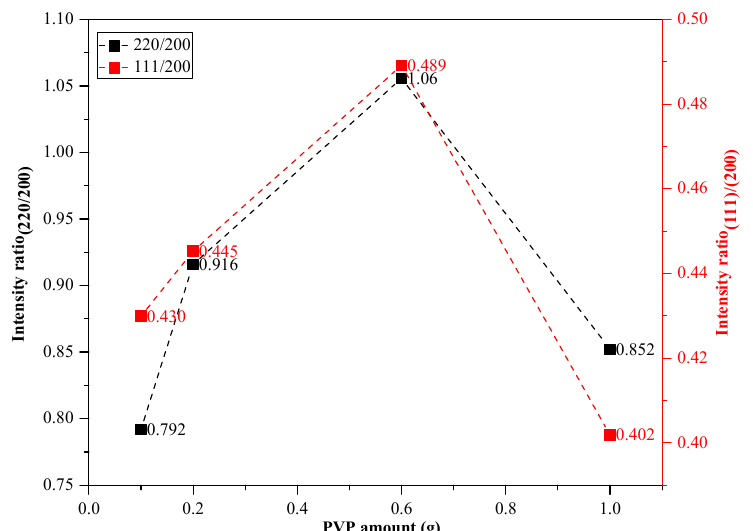
Figure 4. Effect of PVP amount on the structural properties of AgCl photocatalysts (intensity ratio of the (111)/(200) crystallographic planes— red line; intensity ratio of the (220)/(200) crystallographic planes— black line).